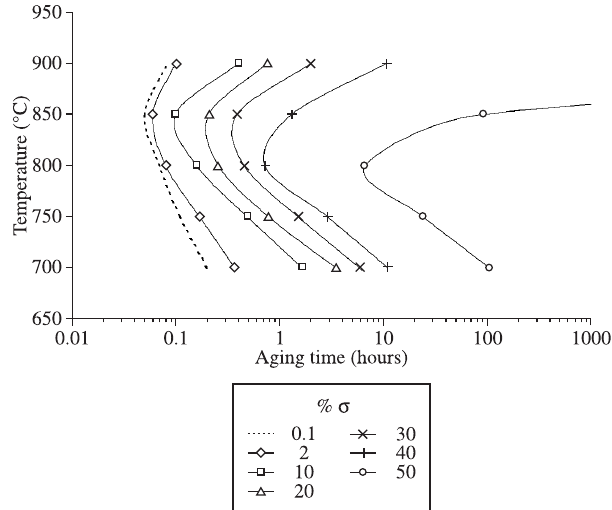
Figure 7. Ferrite and sigma phase content (vol. %) as a function of aging time at 900 °C.